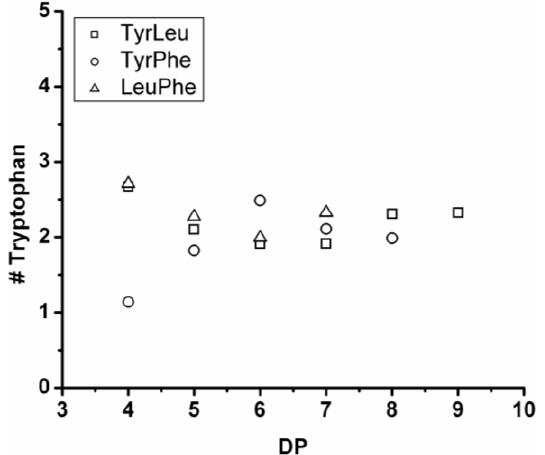
Figure 31. Average amount of tryptophan in co-oligomers based on three amino acids.